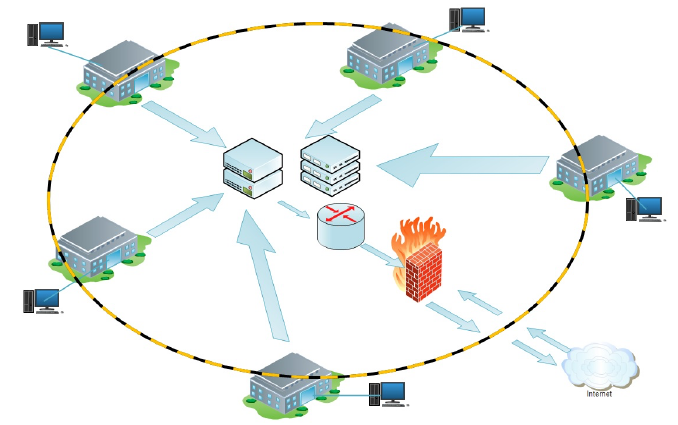
Fig. 2. Infrastructure ring network diagram